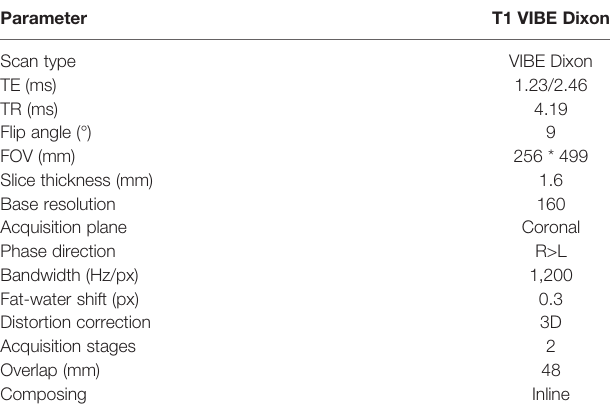
TABLE 1 | MRI acquisition